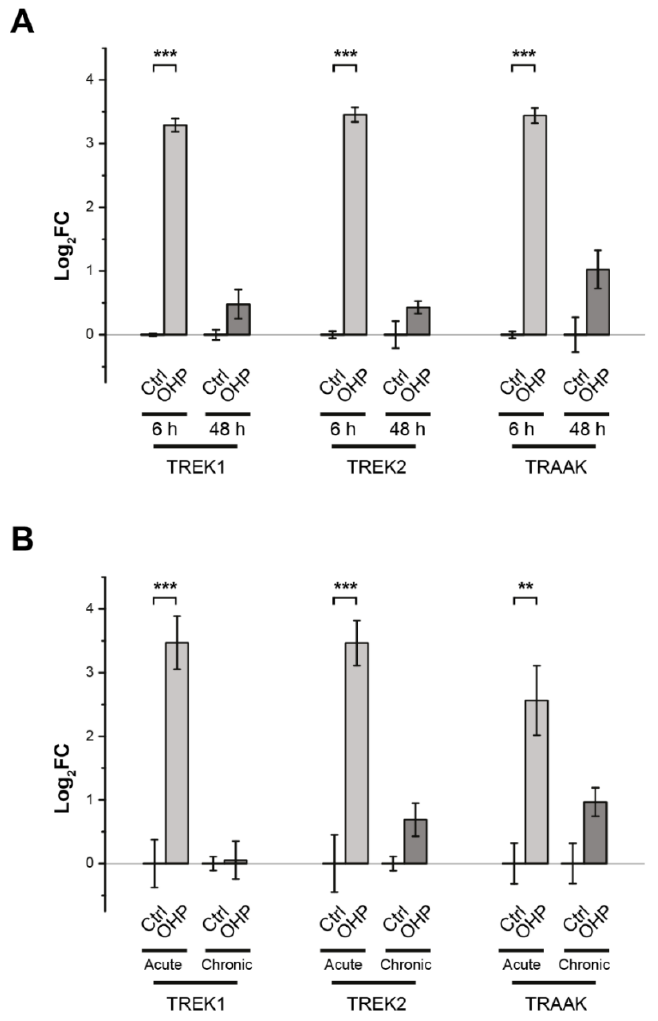
Figure 1. Oxaliplatin transiently affects the transcription of TREK-1, TREK-2, and TRAAK channels. Each bar represents the mean ± SEM of treated vs. control log 2 FC of gene expression, as measured through real-time quantitative PCR (RT-qPCR). ( A ) For each channel, oxaliplatin (OHP)-induced changes in mRNA level were measured in cultured dorsal root ganglion (DRG) cells after 6 h of treatment and 42 h later ( n = 2 biological replicates, each in technical triplicate). ( B ) mRNA expression from DRG cells was measured upon in vivo acute and chronic OHP treatment and compared with the untreated counterpart ( n = 4 biological replicates, each in technical triplicate). In both panels, controls are normalized to zero. ** p -value < 0.01, *** p -value < 0.001; Bonferroni-corrected multiple t - tests.